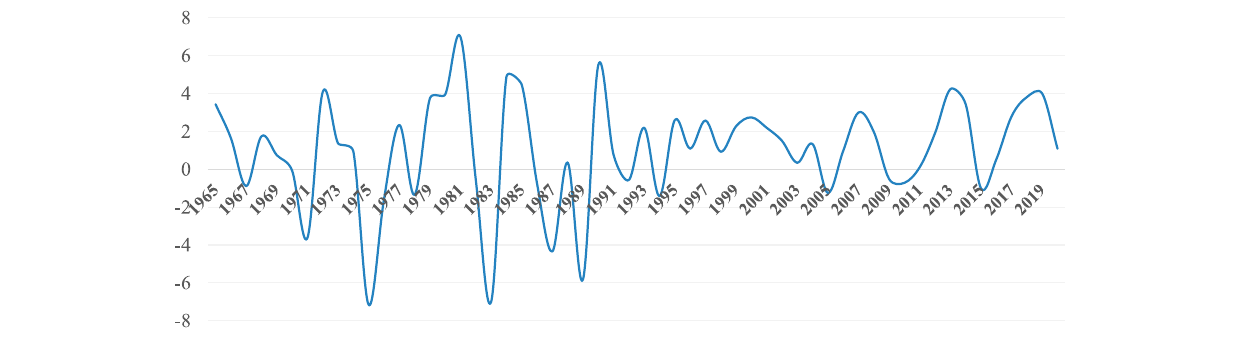
FIGURE3 | Trend ofthe annual percentage growth rateof gross domestic product per capita. Source: World Development indicator, https://data.worldbank.org/